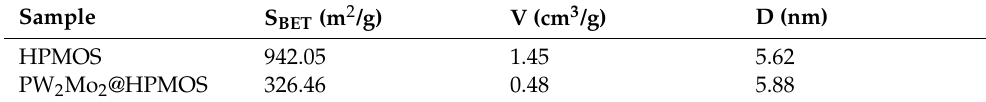
Figure 4. Nitrogen adsorption-desorption isotherms ( a ) and the corresponding pore size distribution curves ( b ) of HPMOS and PW 2 Mo 2 @HPMOS. Table 1. The speci fi c surface area, pore volume, and pore diameter of the samples.